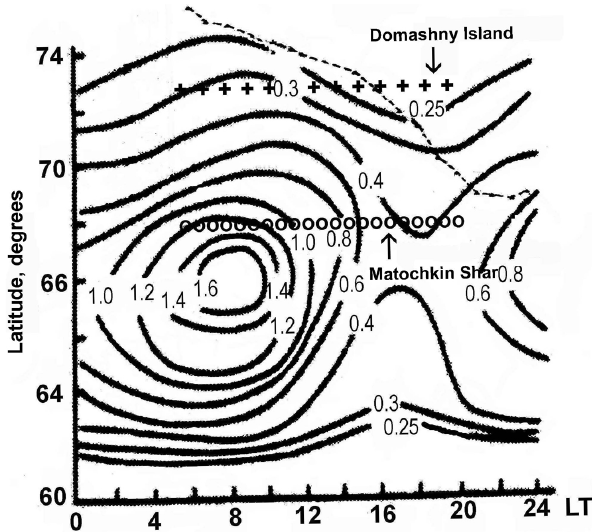
(frequency 32MHz) at high latitudes of the Northern Hemisphere at geomagnetic disturbance K p = 4 in the coordinates: local time – corrected geomagnetic latitude (CGL) according to Zhulina et al. (1989). The figures at the isolines give absorption in decibels. The crosses mark the locations of Domashniy Island according to CGL, and the circles show the locations of the observatory Ma- tochkin Shar